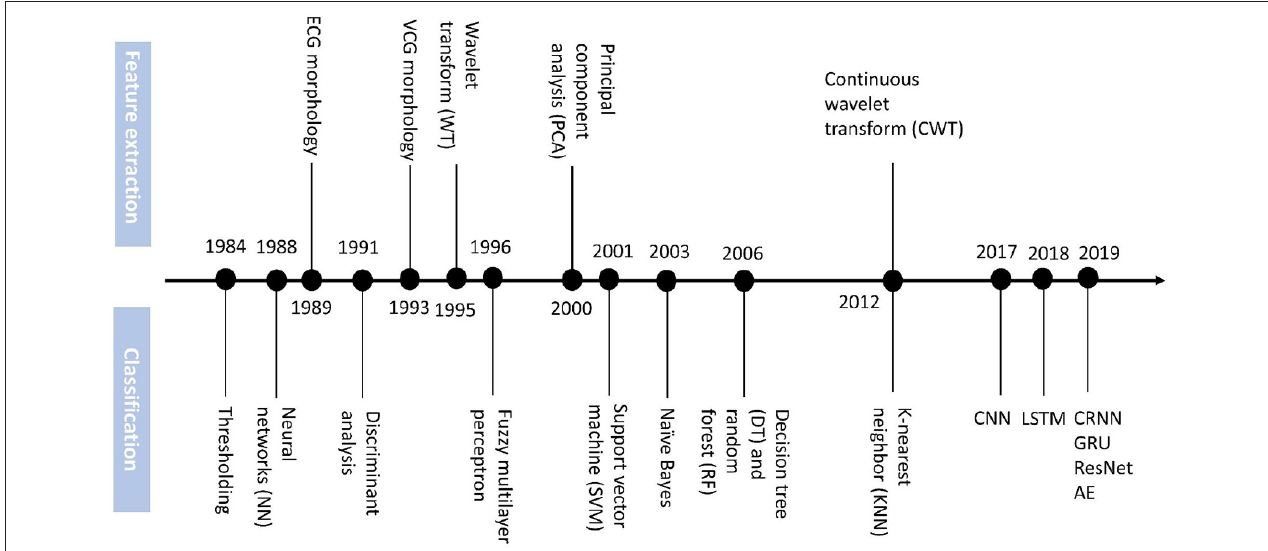
FIGURE 2 | Timeline of technology advances of feature extraction and classification methods for MI